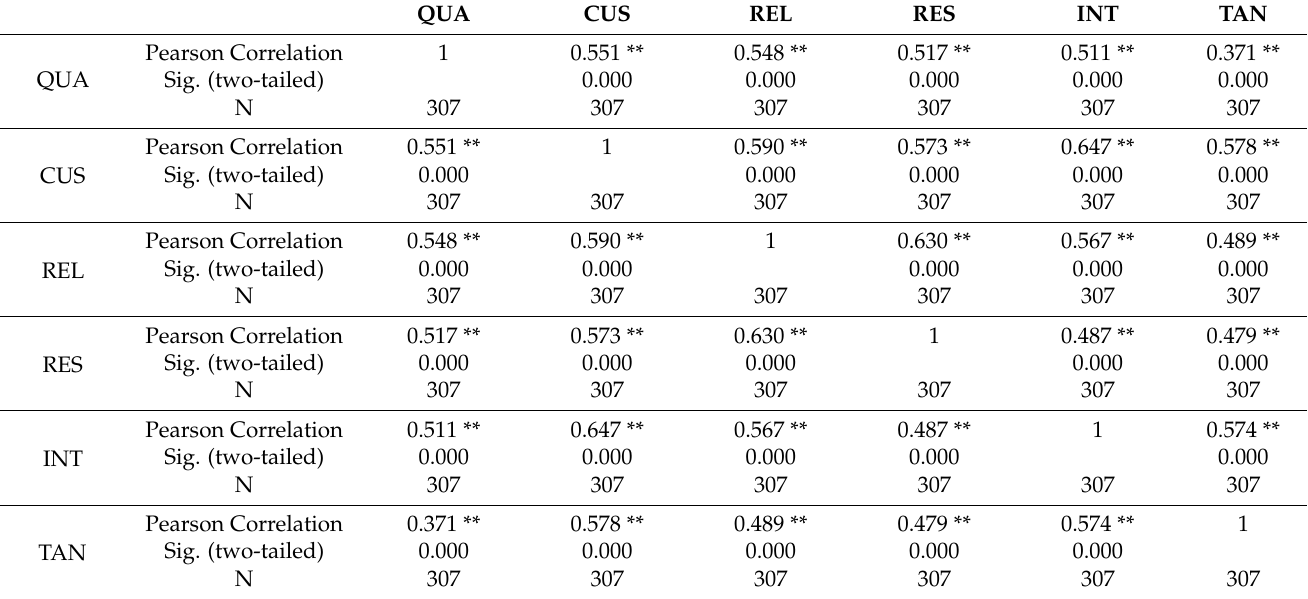
Table 8. Correlations.